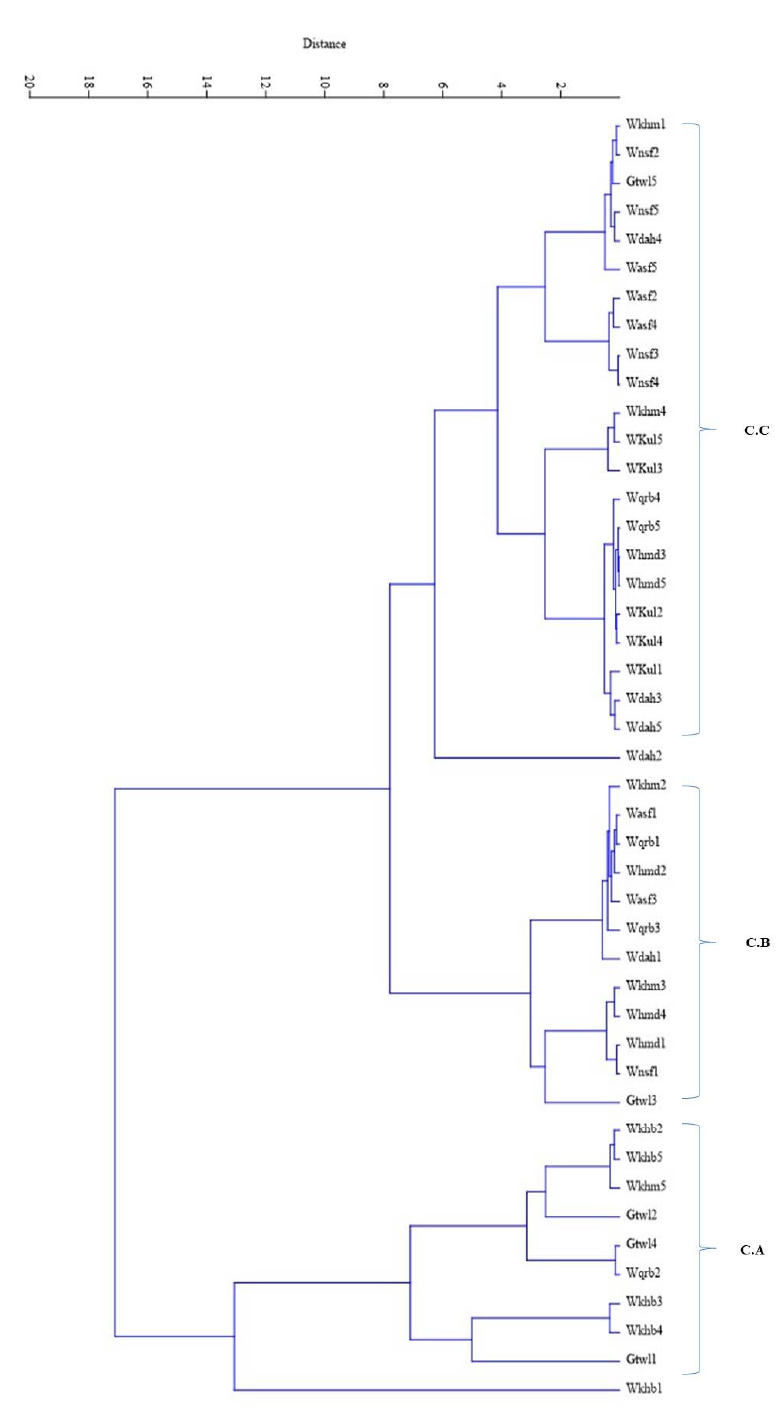
Figure 2. UPGMA dendrogram for the 20 populations of R. epapposum